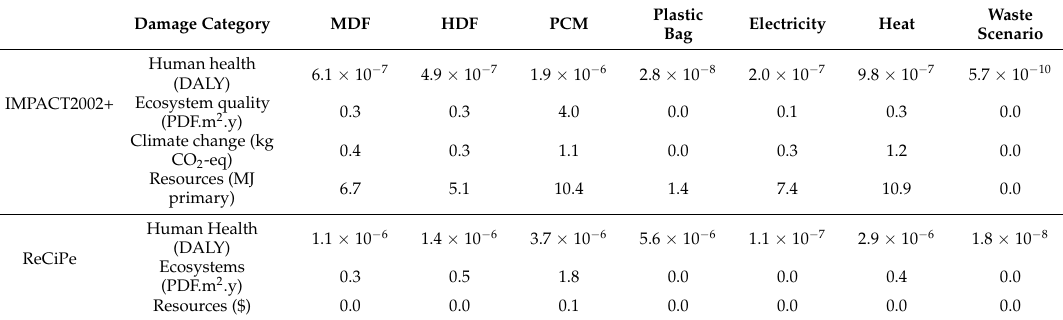
Table 5. Damage assessment results of a PCM panel (0.00153 m 3 ) for materials based on two impact assessment